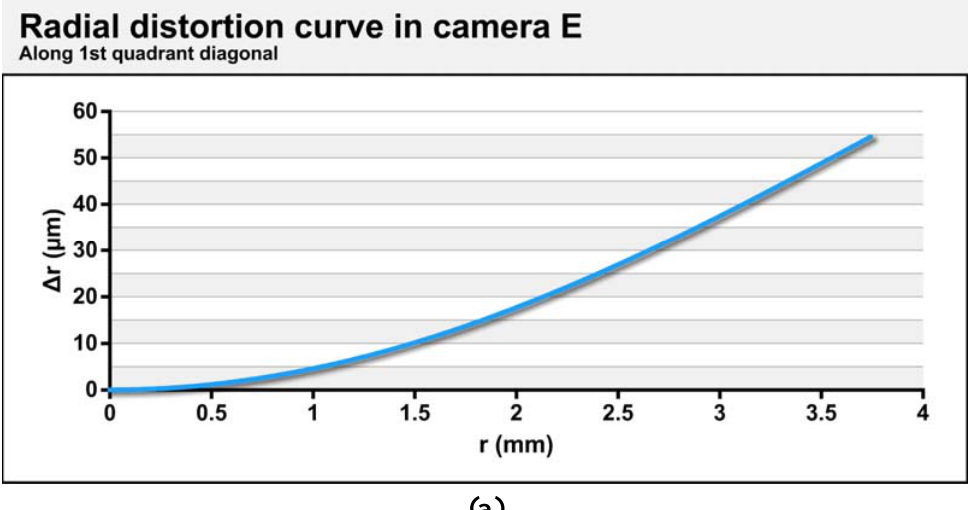
Figure 8. Radial distortion curve for the camera E (a). Curves of radial distortion in the rest of the cameras with respect to camera E